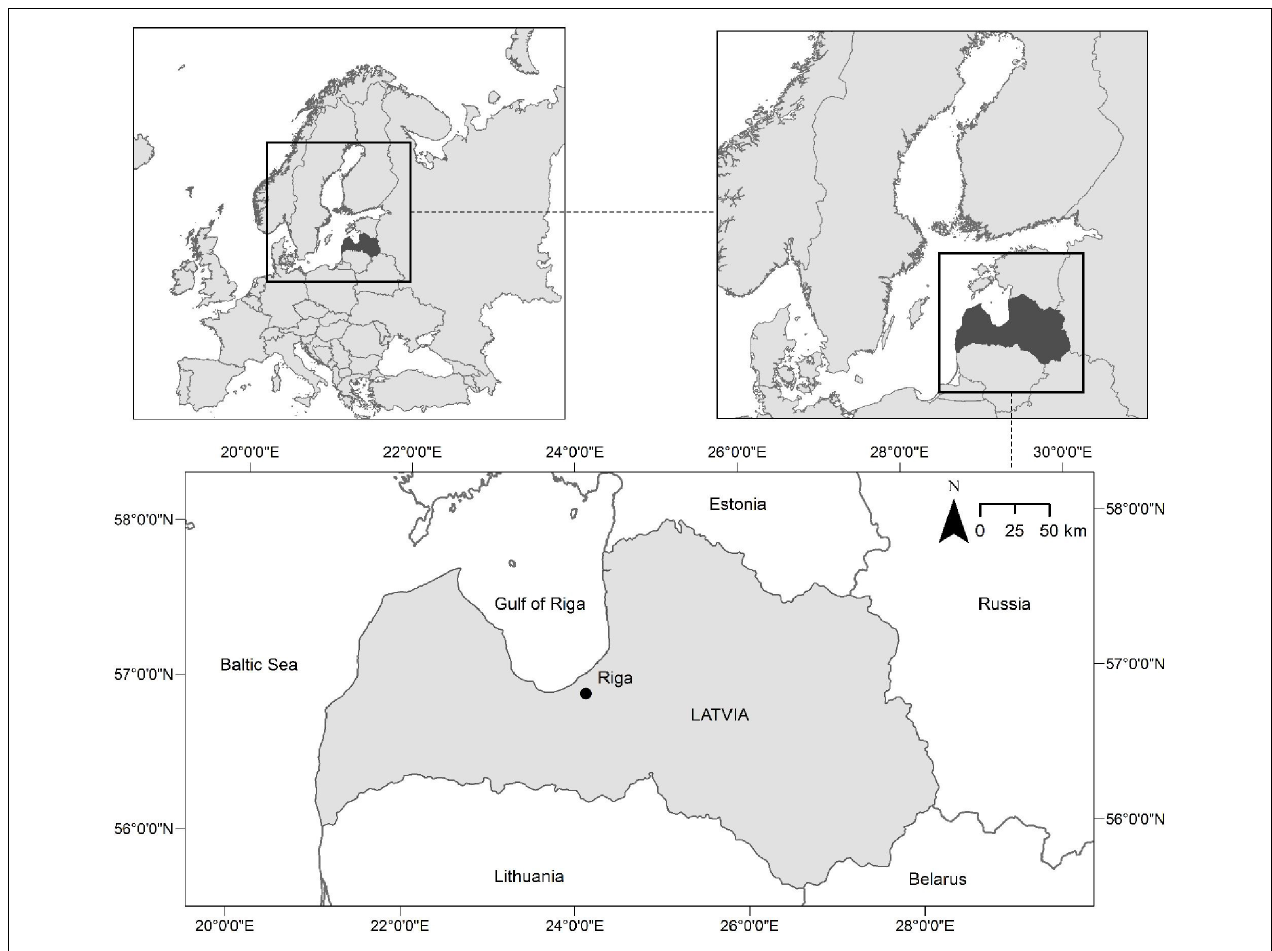
FIGURE 1 | The location of the study